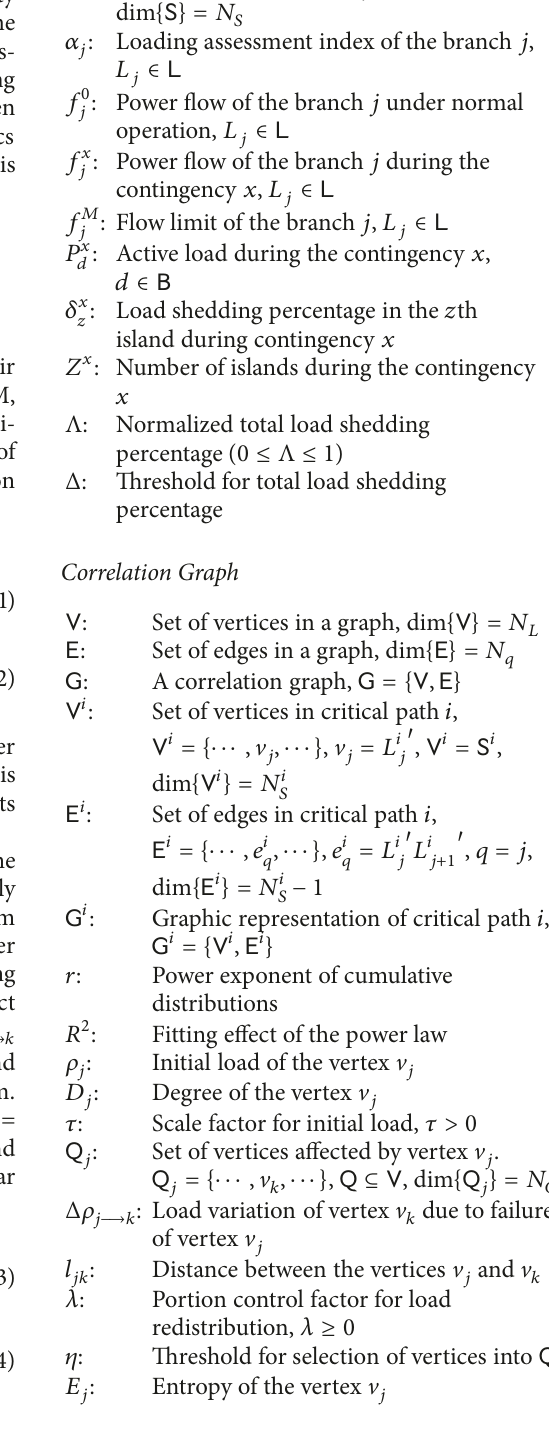
Symbols Electrical